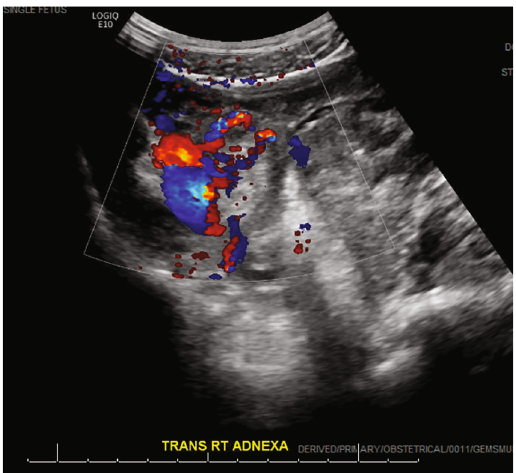
Figure 1: Transvaginal ultrasound of right adnexa. RT: right; TRANS: transverse.